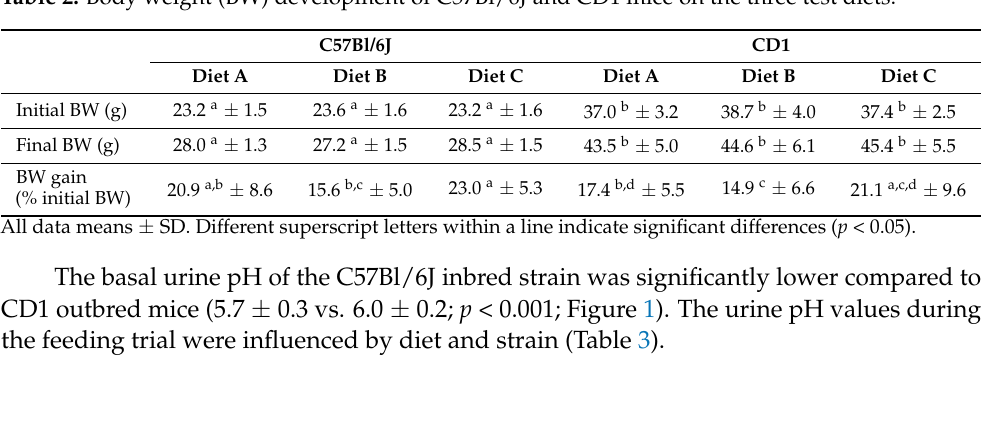
Table 2. Body weight (BW) development of C57Bl/6J and CD1 mice on the three test